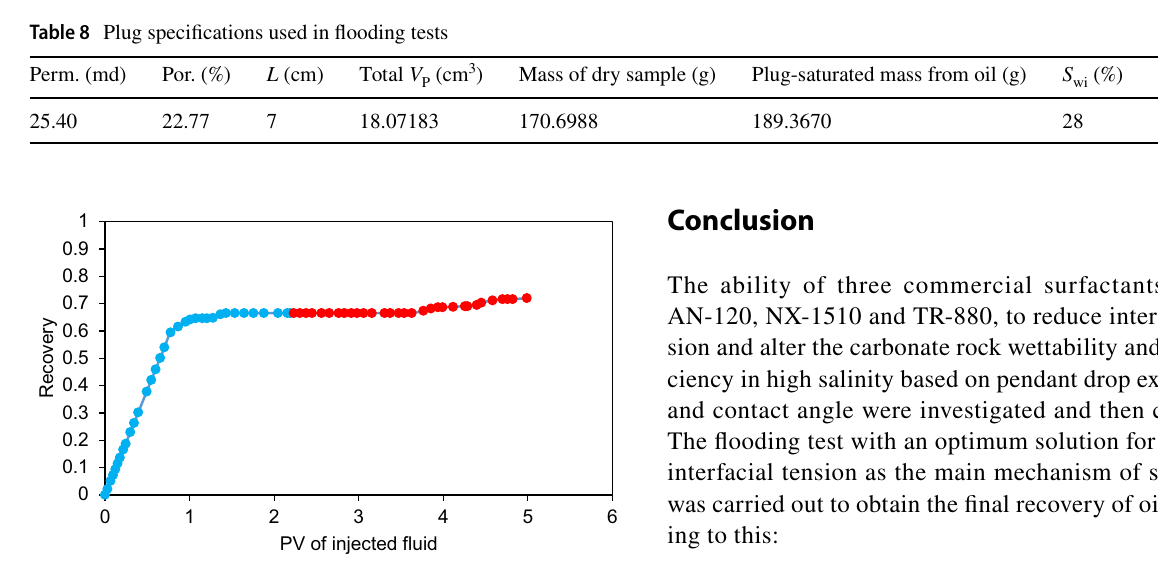
Fig. 13 Amount of production generated by flooding the formation saline water and TR-880 solution at a concentration of 1000 ppm with formation saline water base at a temperature of 351.15 K